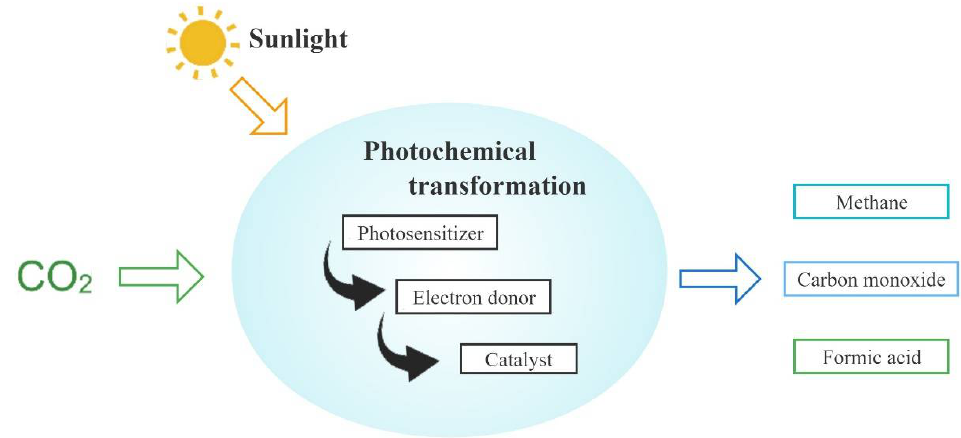
Figure 12. Mechanism of photochemical transformation of CO 2 . Adapted with permission from [192], Elsevier, 2019.